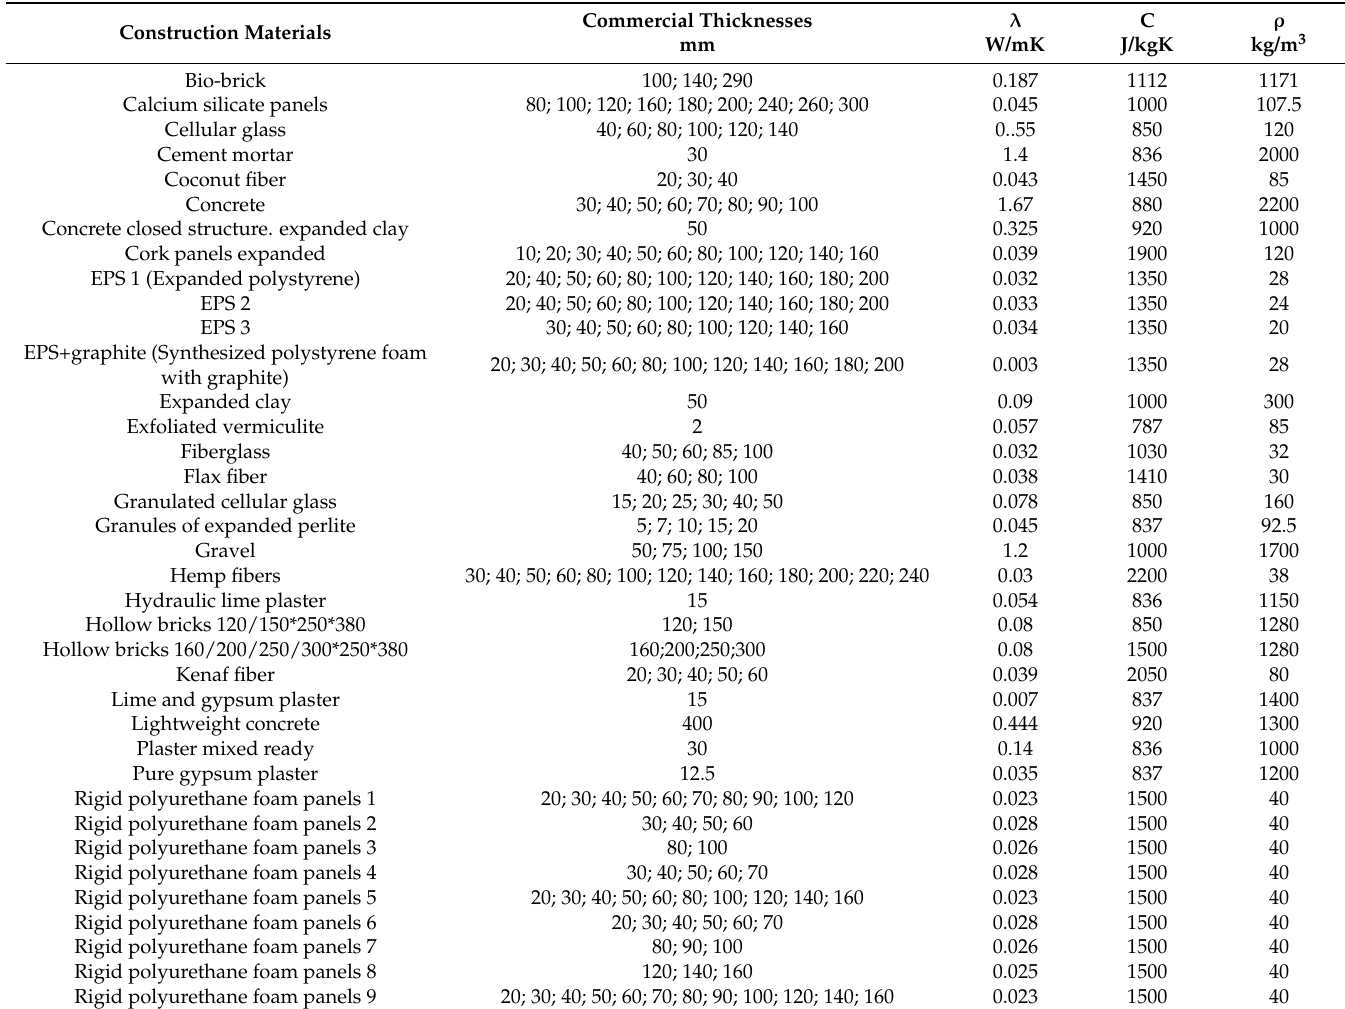
Table 2. Thermo-physical properties of the studied building